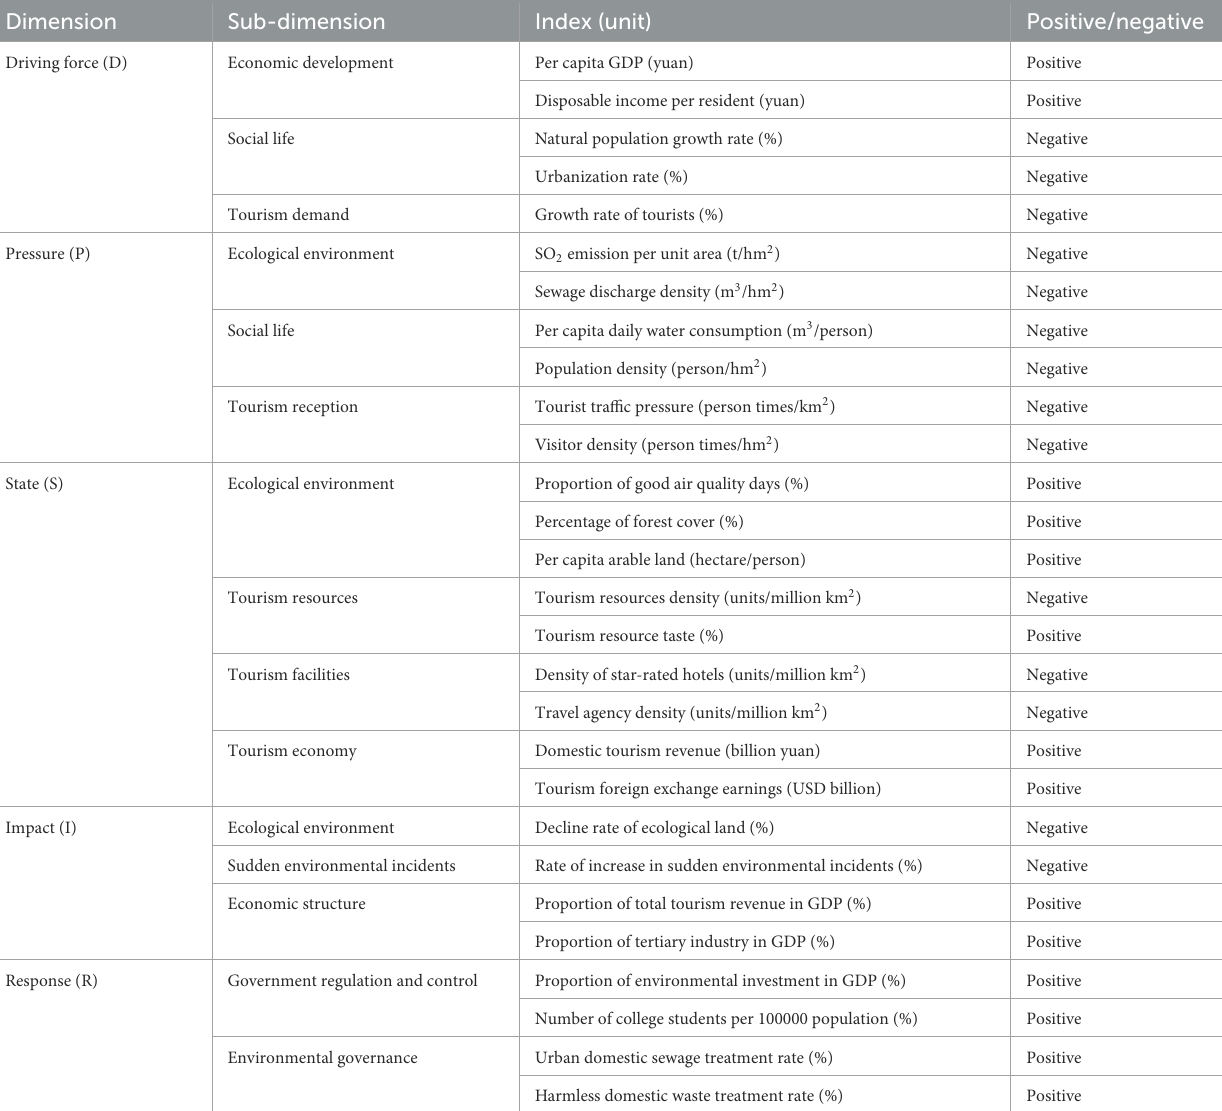
TABLE 3 Tourism ecosystem health evaluation index